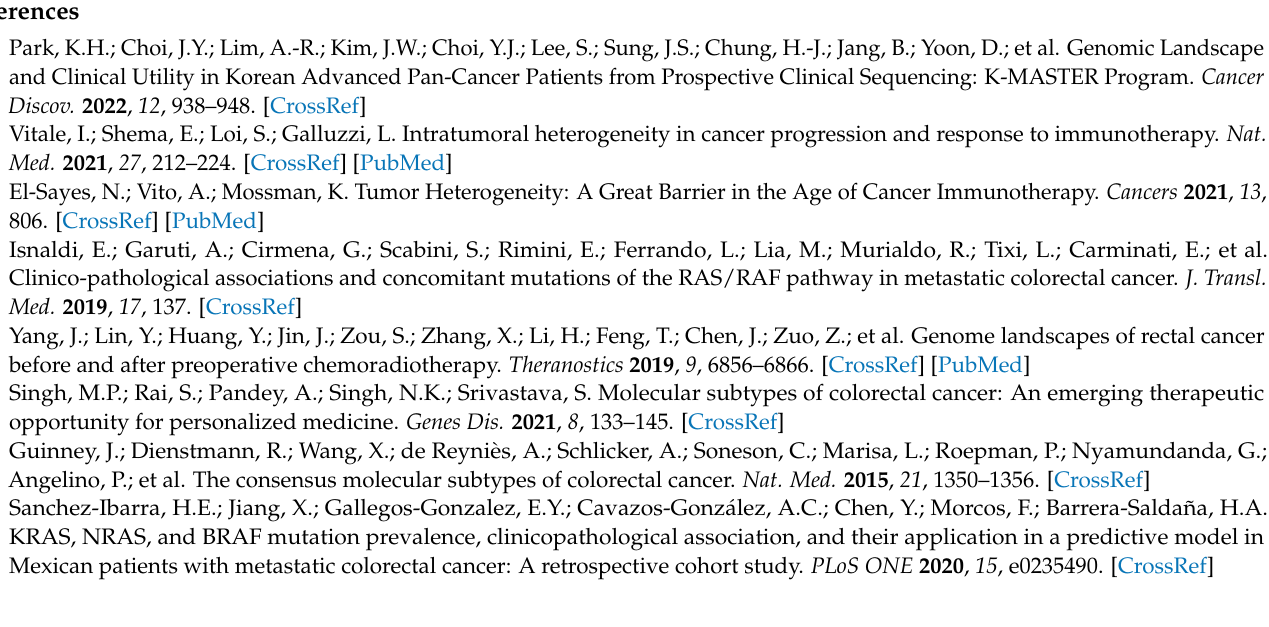
Table S1: Clinical and demographic data of the studied cohort; Table S2: Descriptive statistics of mutation levels (allelic frequencies) of all studied mutations; Table S3: Expressing associations between mutation levels via risk ratios RR1, RR2, and RR3; Table S4: Models used for OR, RR1, RR2, and RR3 calculation related to mutations status and tumor pathological features; Table S5: Risk estimation calculations using the models presented in Table